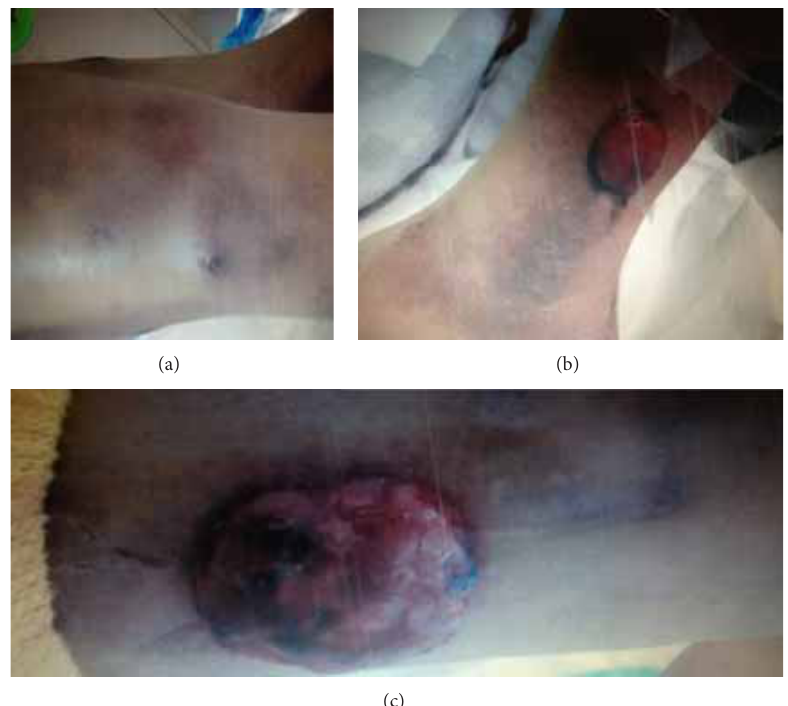
Figure 1: Physical exam of the right thigh revealed two fluctuant, well-circumscribed, circular lesions approximately 3cm in diameter that were tender to palpation and non-mobile (a). Examination of the left lower extremity showed a fleshy-appearing, pinkish, ovular exophytic mass approximately 5cm in diameter that was tender to palpation (b) and